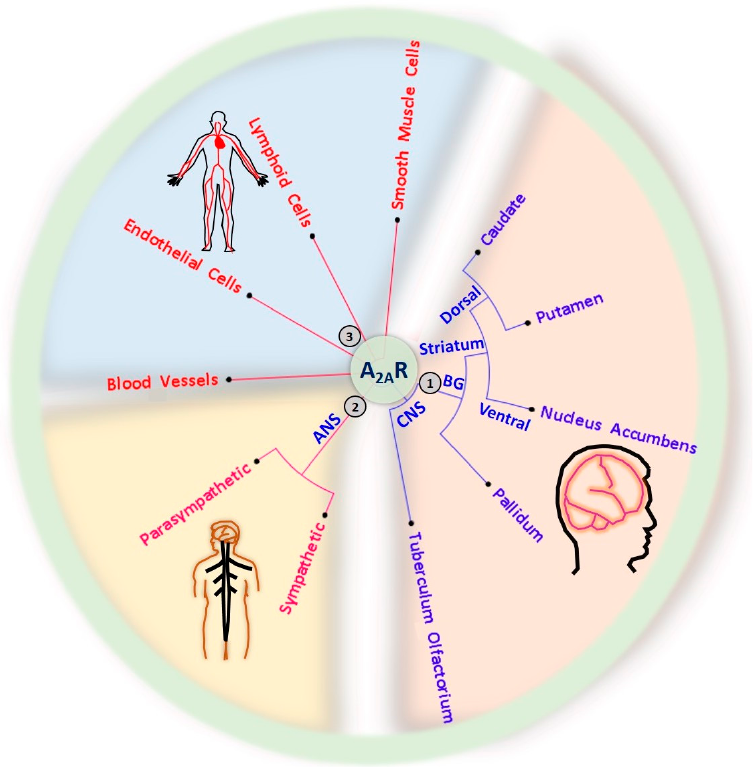
Figure 2. Expression of A 2A Rs in the central nervous system (CNS), autonomic nervous system (ANS), circulatory system, and musculoskeletal system. (1) CNS A 2A Rs are mainly expressed in the basal ganglia (BG), including the dorsal pallidum, the nucleus accumbens in the ventral part of the striatum, and the dorsal striatum comprising the caudate and putamen. (2) A 2A Rs are also expressed in the sympathetic and parasympathetic ANS. (3) The distribution of A 2A Rs is not limited to the nervous system; A 2A Rs are also found in the circulation system, including heart, blood vessels, lymphoid cells (immune cells), and smooth muscle cells of the musculoskeletal system.